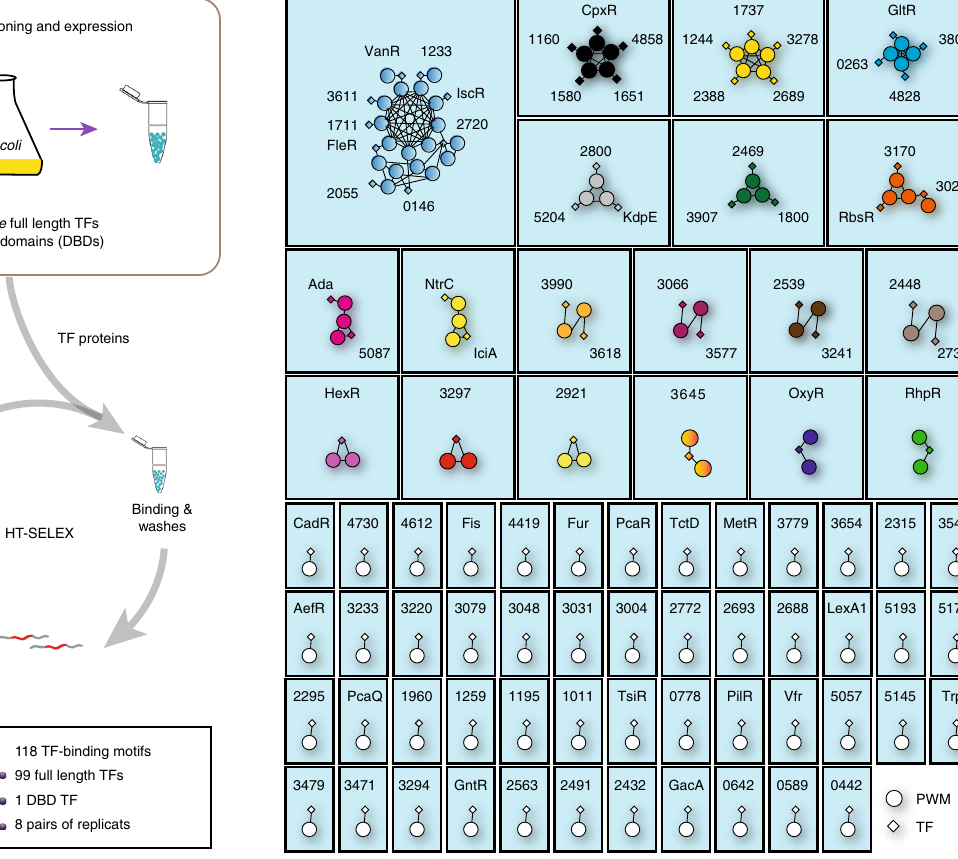
Fig. 1 Network representation of the similarity of the PWMs from the HT-SELEX assay. a Schematic description of protein expression and high- throughput SELEX process. b Network of similarity of the obtained PWMs. Diamonds indicate TF genes, and circles indicate individual PWMs. Edges are drawn between a TF and its PWM models, and between similar PWM models (SSTAT similarity score >E-05). The TFs without names are named with their locus tag omitting PSPPH_. TF transcription factor, PWM position weight matrix. See also Supplementary Fig. 1, Supplementary Data 1, Supplementary Data 3, and Supplementary Table